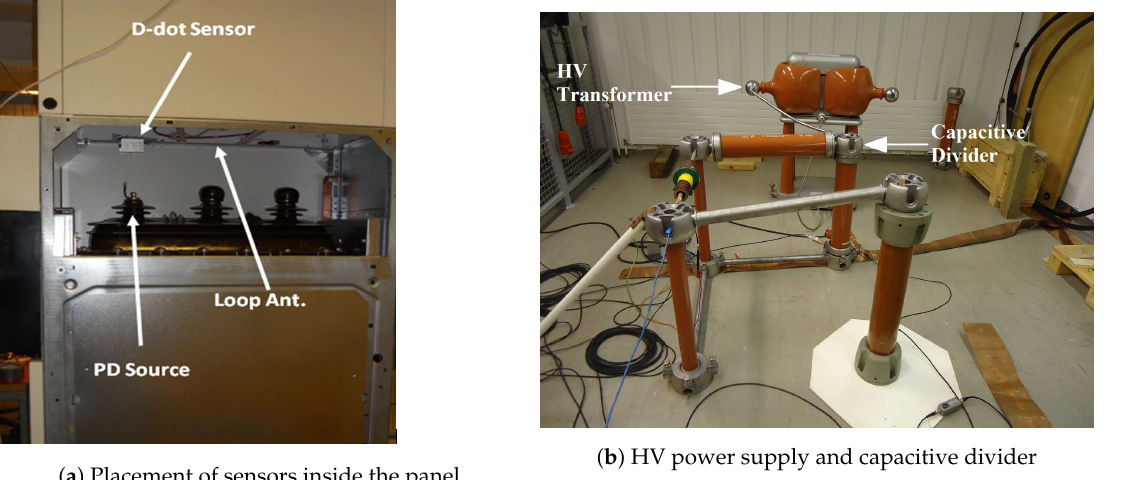
Figure 11. HV Power